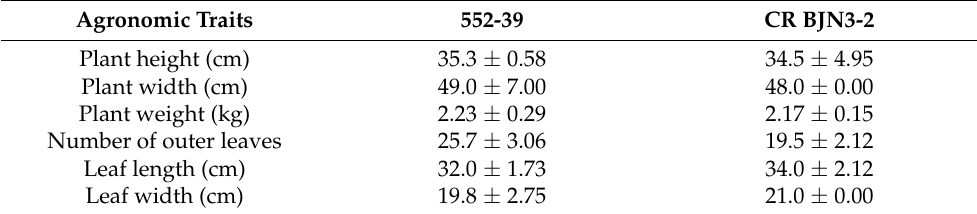
Table 4. Agronomic trait evaluation of recurrent parent and pyramided